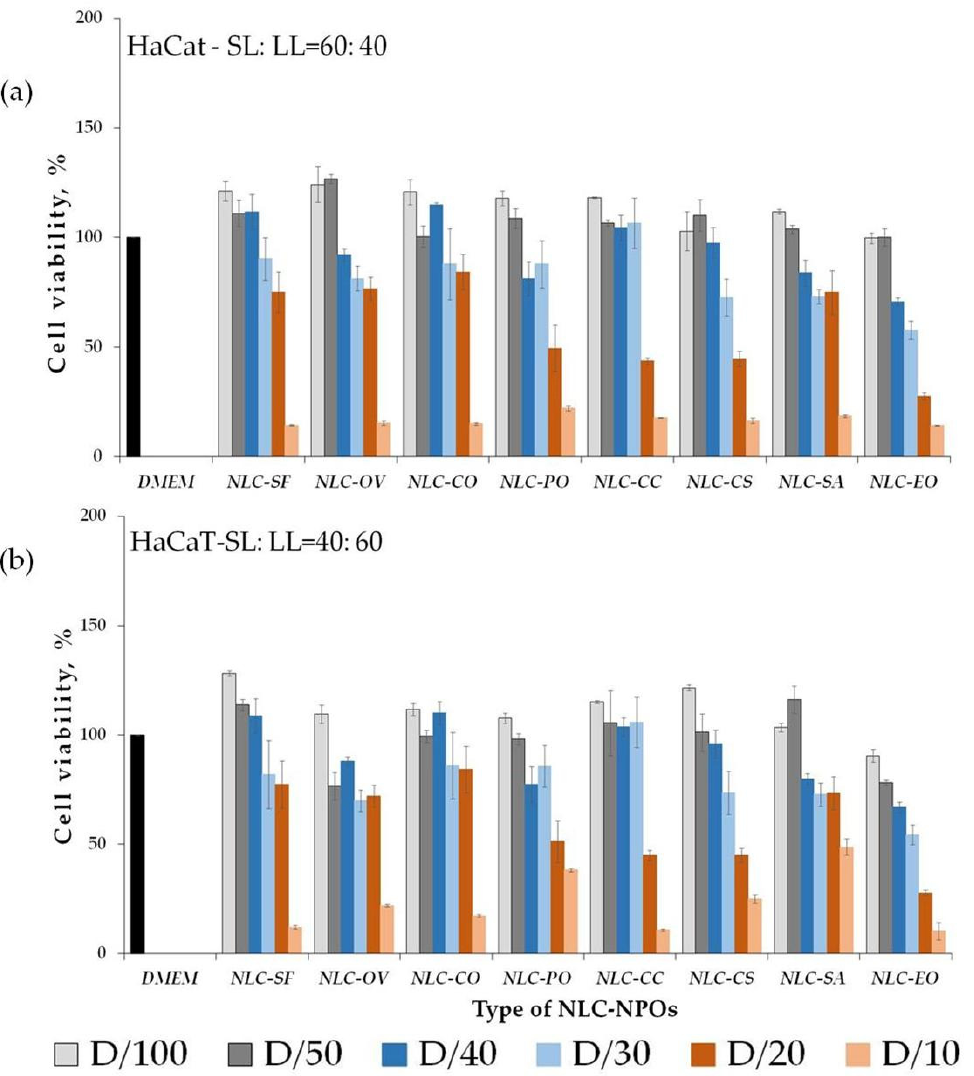
Figure 5. Cytocompatibility (viability %) of keratinocytes (HaCaT): ( a ) 60:40; ( b ) 40:60 of fibroblasts with all the nanoparticle suspensions; dilution (D) 1/10, 1/20, 1/30, 1/40, 1/50, and 1/100; Medium (DMEM) was used as comparison (positive control) (mean value ± SD; n = 3).